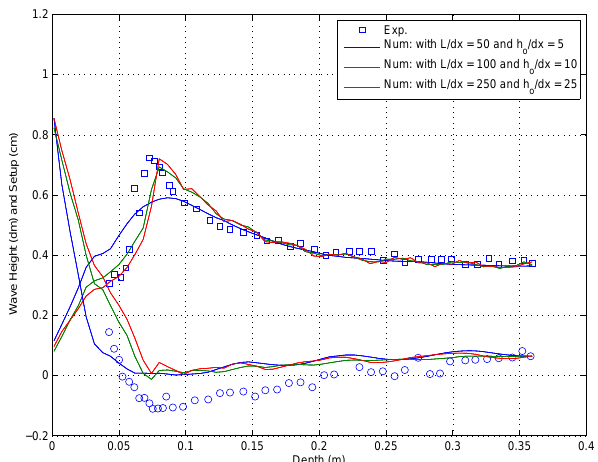
Fig. A3. Computed and measured wave heights and setup for the Hansen and Svendsen case 051041 ( kh o = 0 . 641, H/h o = 0 . 11).